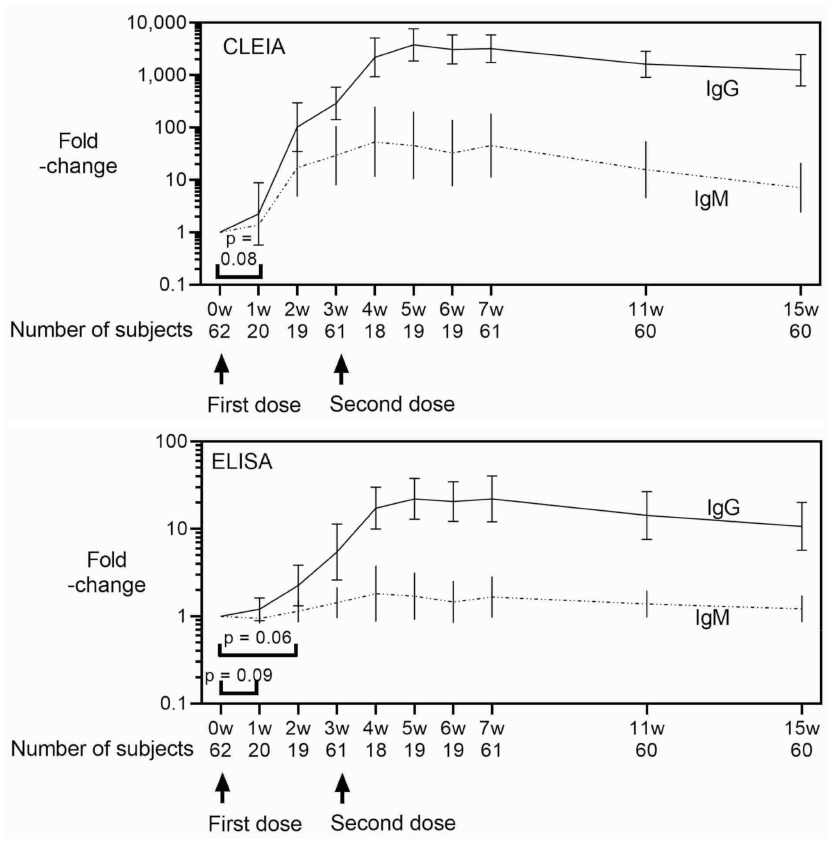
Figure 1. SARS-CoV-2 S1 protein-specific antibody levels measured by CLEIA and ELISA. Antibody titer ratios measured by CLEIA (upper panel) and ELISA (lower panel) are shown (geometric mean ± geometric standard error). Forty-two students (started vaccination in May 2021) had specimens collected before vaccination and at 3, 7, 11, and 15 weeks after vaccination. Twenty healthcare workers (started vaccination in April) had specimens collected at all time points. Arrows indicate vaccination timing. One of the male students lacks measurements at the weeks after 11. One of the female healthcare workers lacks measurements at week 2 and at the weeks after 4. Another female healthcare worker lacks a measurement at week 4. Arrows indicate vaccination. Unless otherwise noted, differences from pre-vaccination are significant by paired t-test using log-transformed value.